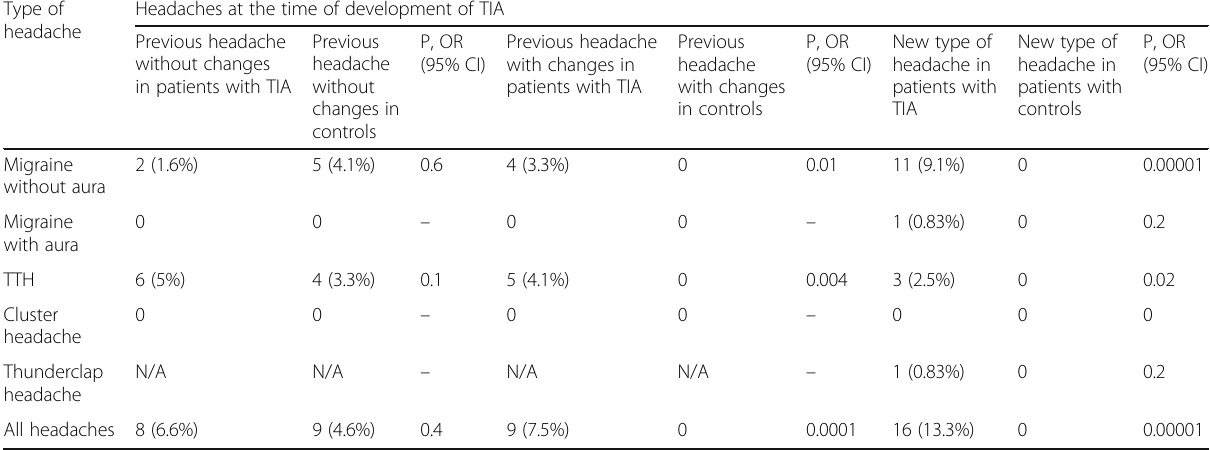
Table 5 Headaches at the time of TIA onset ( n = 120) and at admission of controls ( n = 192) Type of